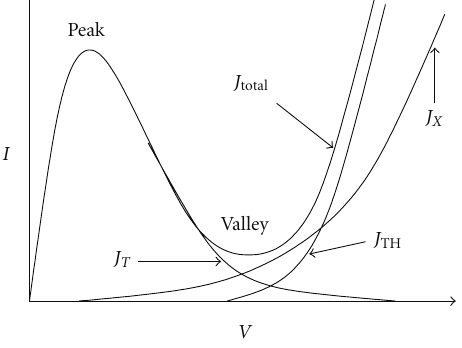
Figure 1: Esaki tunnel diode I - V